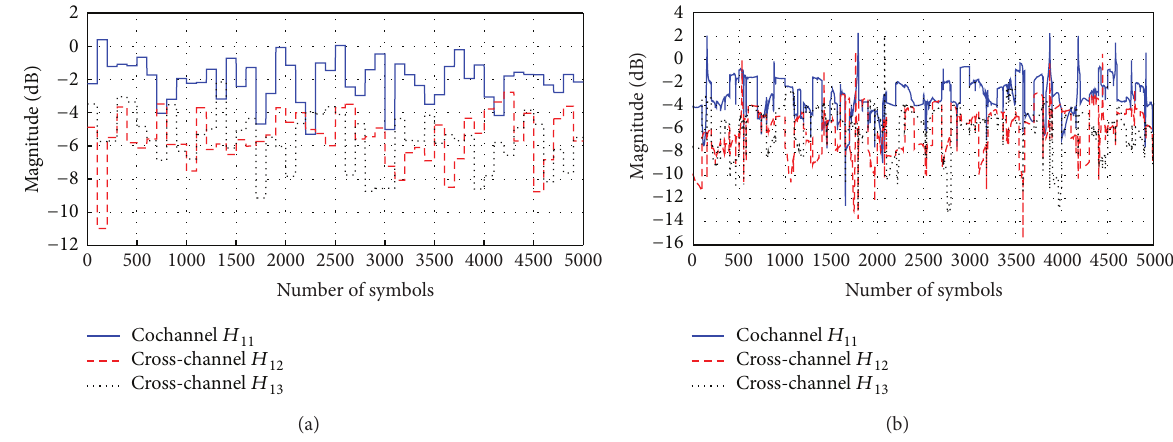
Figure 3: Normalized fading envelope of the PS 3D triple-polarized channel model: (a) MS mobility = 0km/h and (b) MS mobility = 60 km/h.